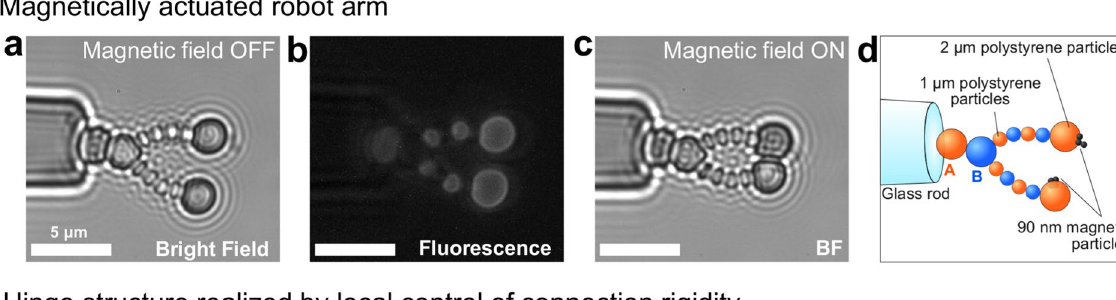
particles with diameters of 1 μ m and 2 μ m were used in the arm part, and 2- μ m polystyrene particles coated with 90-nm magnetic particles were used in the arm tip. Particles A and B were alternately placed one by one. Only strand A was labeled with a HEX fluorescent dye on its 5 ′ end so that the A particles and B particles could be distinguished during the assembly process. This structure demonstrates that it is possible to incorporate diverse particles in arbitrary locations. When a permanent magnet was moved close to/away from the chamber, the arm opened and closed accordingly (Fig. 3a and c). This responsive movement is possible because of the flexible con- nection formed by the DNA strands. The flexibility of the DNA connection is controllable by tuning the DNA concentration on the surface of the particles (see Supplementary Information). By reducing the DNA concentration on the particle surface, the bond between particles becomes weak. Figure 3e–h shows a hinge structure formed by incorporating fewer DNA strands into the particles, which in turn are placed at a specific site in the structure. We observed that the structure could bend at the site with these particles when a force was applied to the tip of the structure. This local flexibility control provides an additional degree of freedom to the mechanical function of the robot.